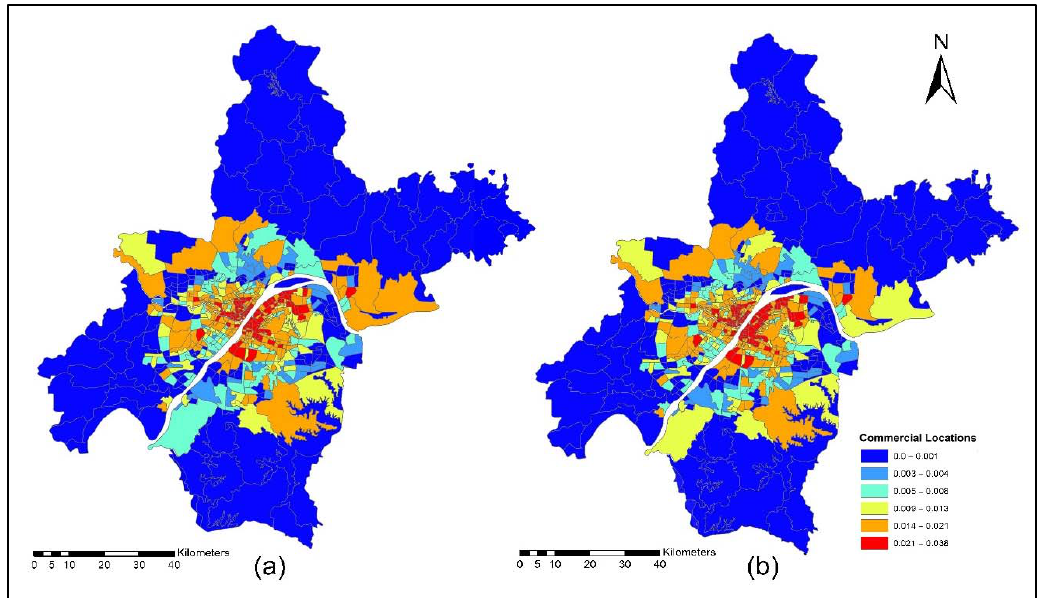
Figure 16. ( a , b ) ISE-estimated commercial locations: ( a ) during the morning peak for the year 2012; ( b ) during the morning peak for the year 2015.